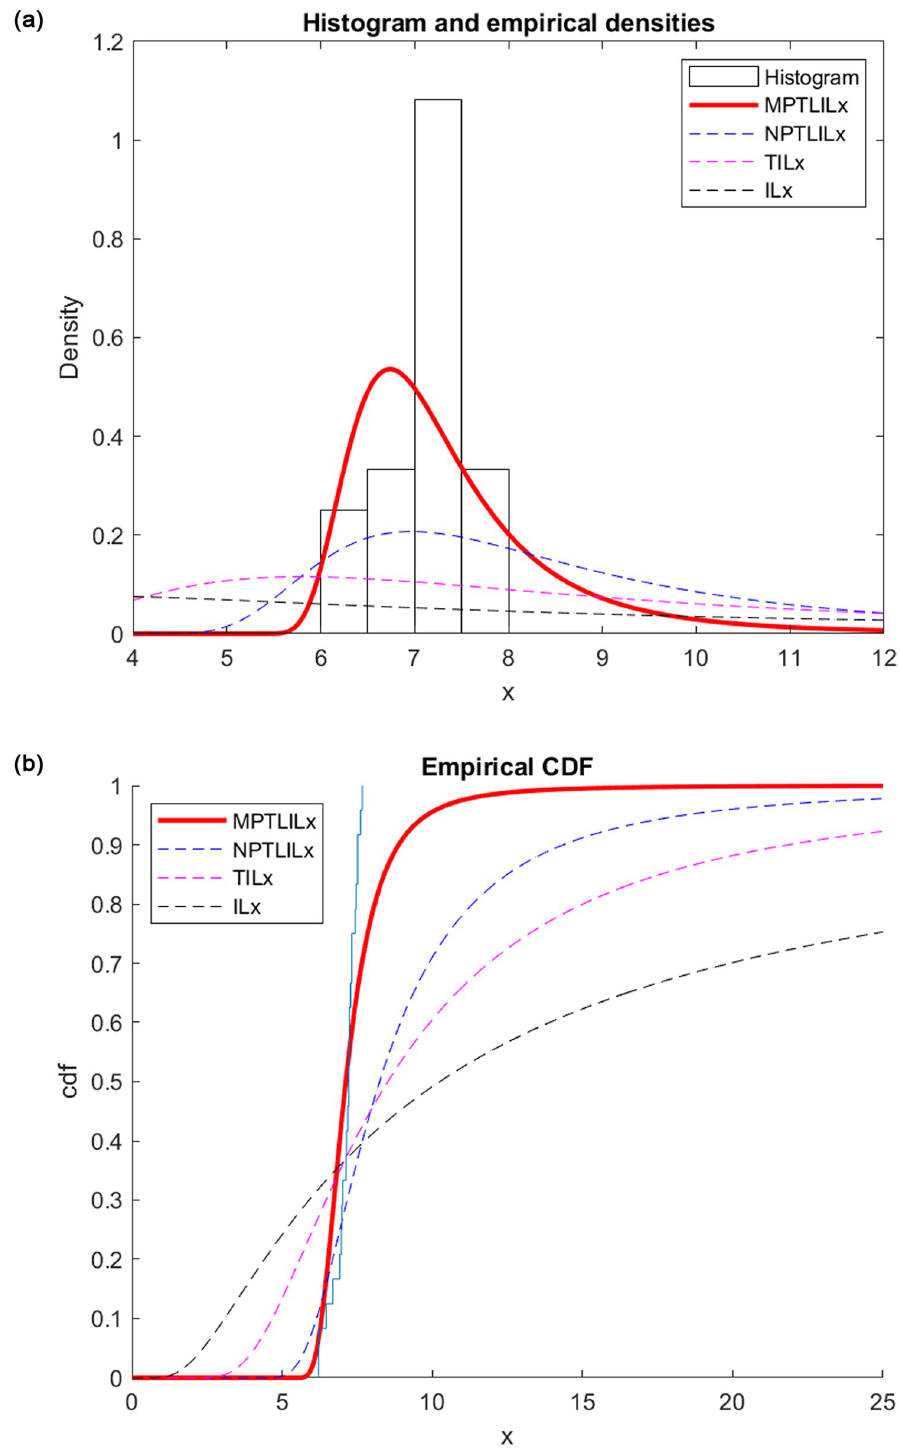
Fig 4. Graphical representation of the empirical pdfs and CDFs (dataset II). (a) pdfs representation. (b) CDFs representation.